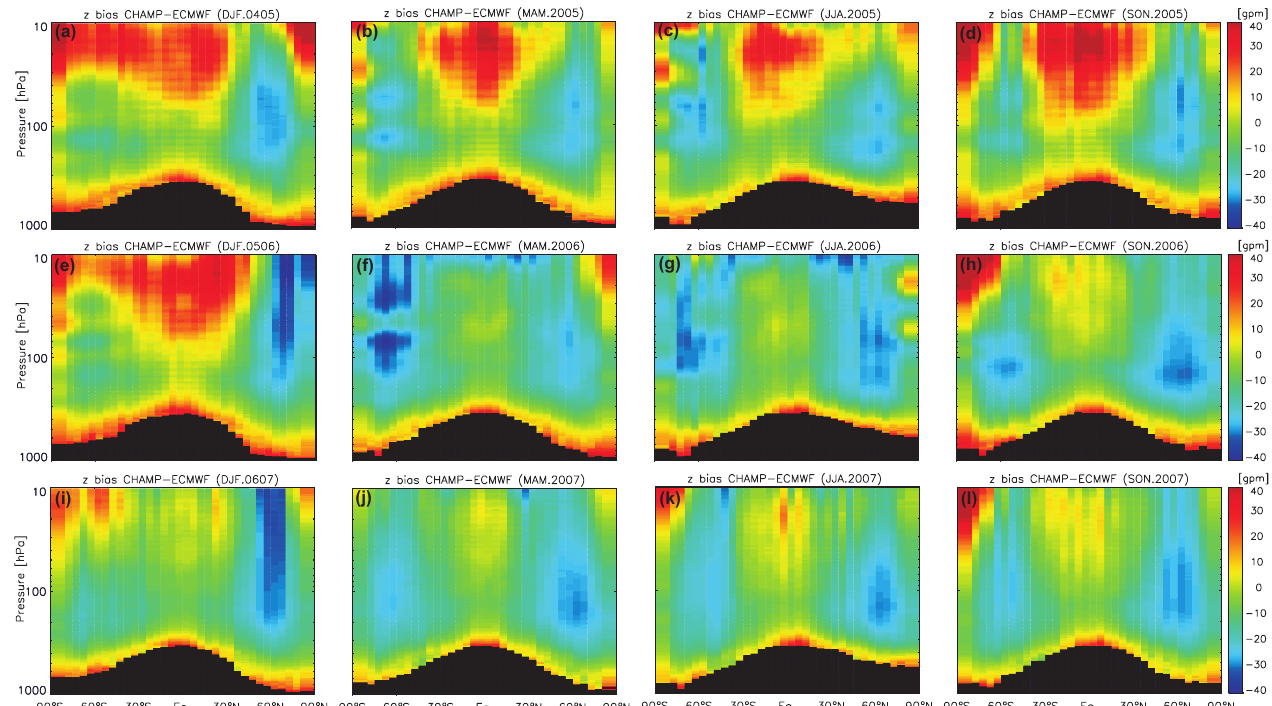
Fig. 9. Zonal mean GPH bias between CHAMP and ECMWF for the pressure (altitude) range 1000–10hPa for different seasons (DJF.0405– SON.2007). The meridional resolution is 5 ◦ between 77.5 ◦ N–77.5 ◦ S and 10 ◦ for 85 ◦ N and 85 ◦ S. The vertical pressure resolution corre- sponds to an altitude resolution of about 200–300m. The black areas denote regions with temperatures above